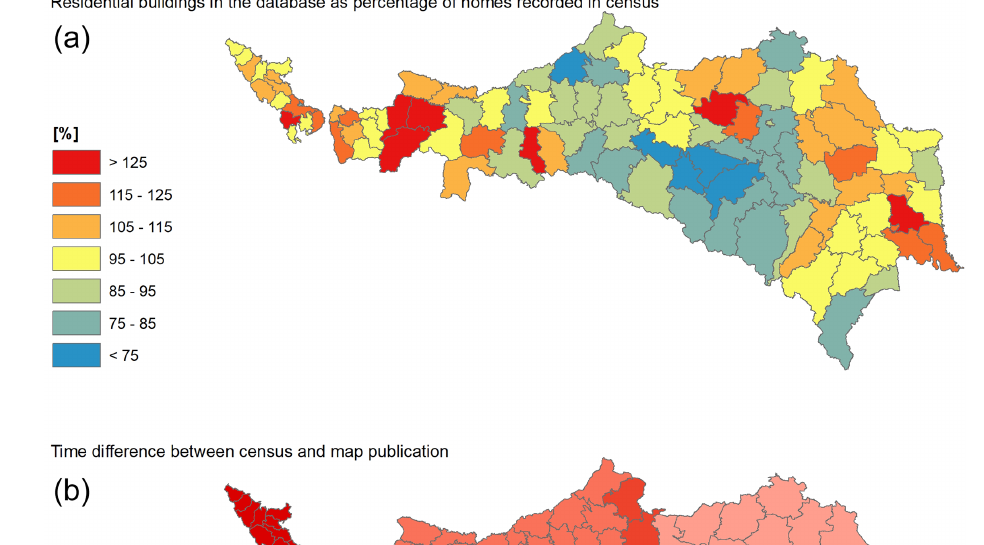
Earth Syst. Sci. Data, 13, 1693–1709,